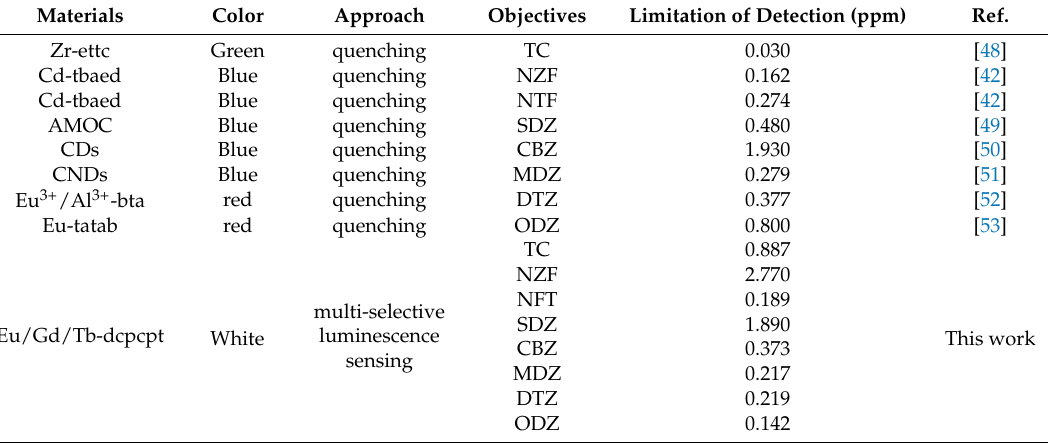
Table 1. Comparison of luminescent materials for sensing